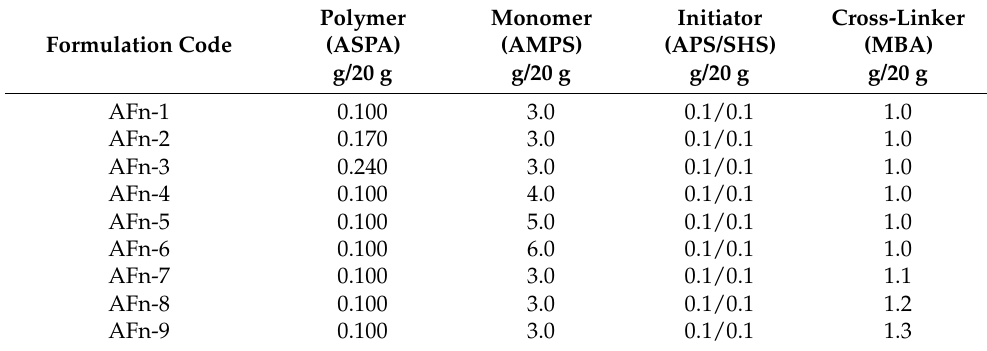
Table 3. Feed ratio scheme for formulation of ASPA-pAMPS